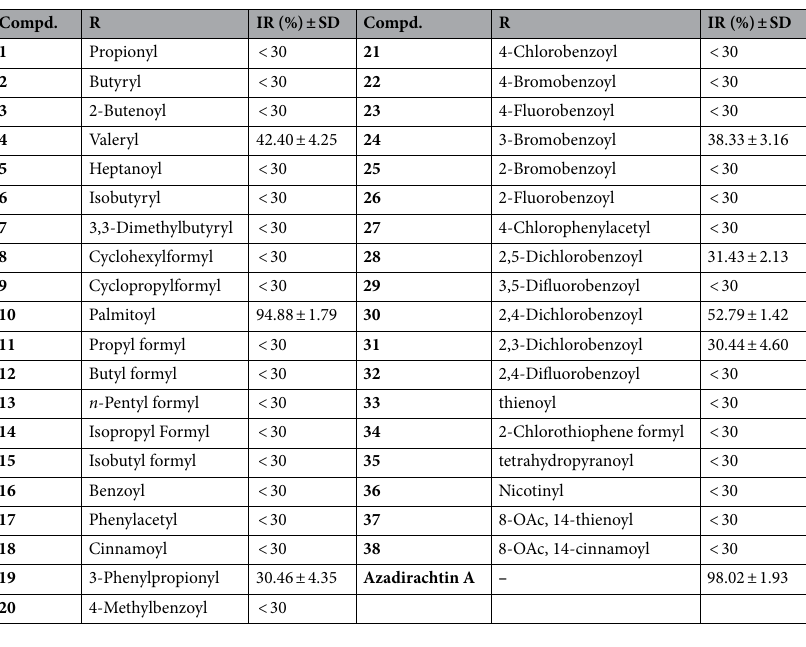
Table 3. The Inhibition Rate (IR) of target compounds against Sf9 cells at 100 μM. The experiments were repeated six times.